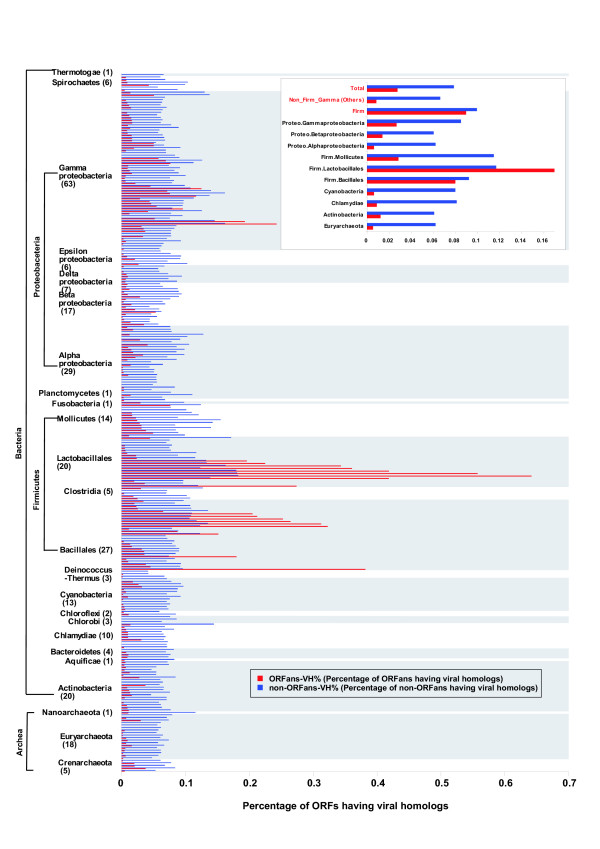
Percentage of microbial ORFs having homologs in viruses for 277 prokaryote genomes. The y-axis shows each of the 277 genomes, grouped according to NCBI's taxonomy classification. For each genome, two percentages are shown: red corresponds to ORFans-VH% (percentage of ORFans having homologs in viruses) and blue corresponds to non-ORFans-VH% (percentage of non-ORFans having homologs in viruses). The major 24 clade names are shown, with the number of organisms in each clade shown in parenthesis. The 24 phylogenetic clades are alternately marked by grey and no background colors. For the species names and taxonomies, please refer to Additional file 1. The inset shows the average percentage values of ORFans-VH% and non-ORFans-VH% in various groups. "Total" corresponds to the averages in all 277 genomes taken together, "Non_Firm_Gamma (Others)" corresponds to the averages in the 148, non-Firmicutes, non-Gamma-proteobacteria genomes and "Firm" corresponds to the 66 Firmicutes in the database. The remaining groups in the inset correspond to the major clades (with at least 10 genomes). The figure clearly shows that except for some Firmicutes, ORFans-VH% is much smaller than non-ORFans-VH%, suggesting that the current evidence from homology supporting the hypothesis that the origin of ORFans is viral is weak at best.